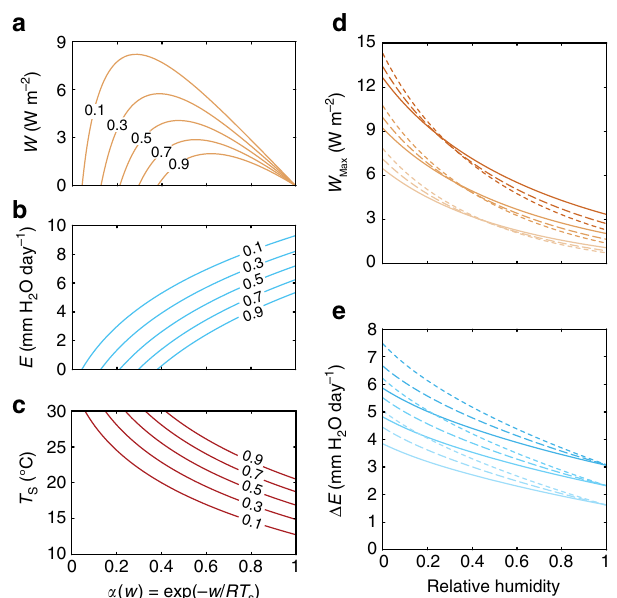
Fig. 2 Steady-state power generation and effects on evaporative losses. a Energy fl uxes, b evaporation rates, and c surface temperatures are calculated as a function of α ( w , T s ) for weather conditions of 200 W m − 2 I , 16 °C T a , 101.3 kPa P , and 2.7 m s − 1 (6 mph) u at 5 values of RH (mild conditions). d Maximum energy fl ux and e water saved from evaporation as a function of RH at cool ( pale , 12 °C, 150 W m − 2 ), mild ( neutral , 16 °C, 200 W m − 2 ), and warm ( dark , 20 °C, 250 W m − 2 ) weather conditions and three wind speeds: 1.8 (4 mph, solid ), 2.7 (6 mph, dashed ), and 3.6 m s − 1 (8 mph, dotted